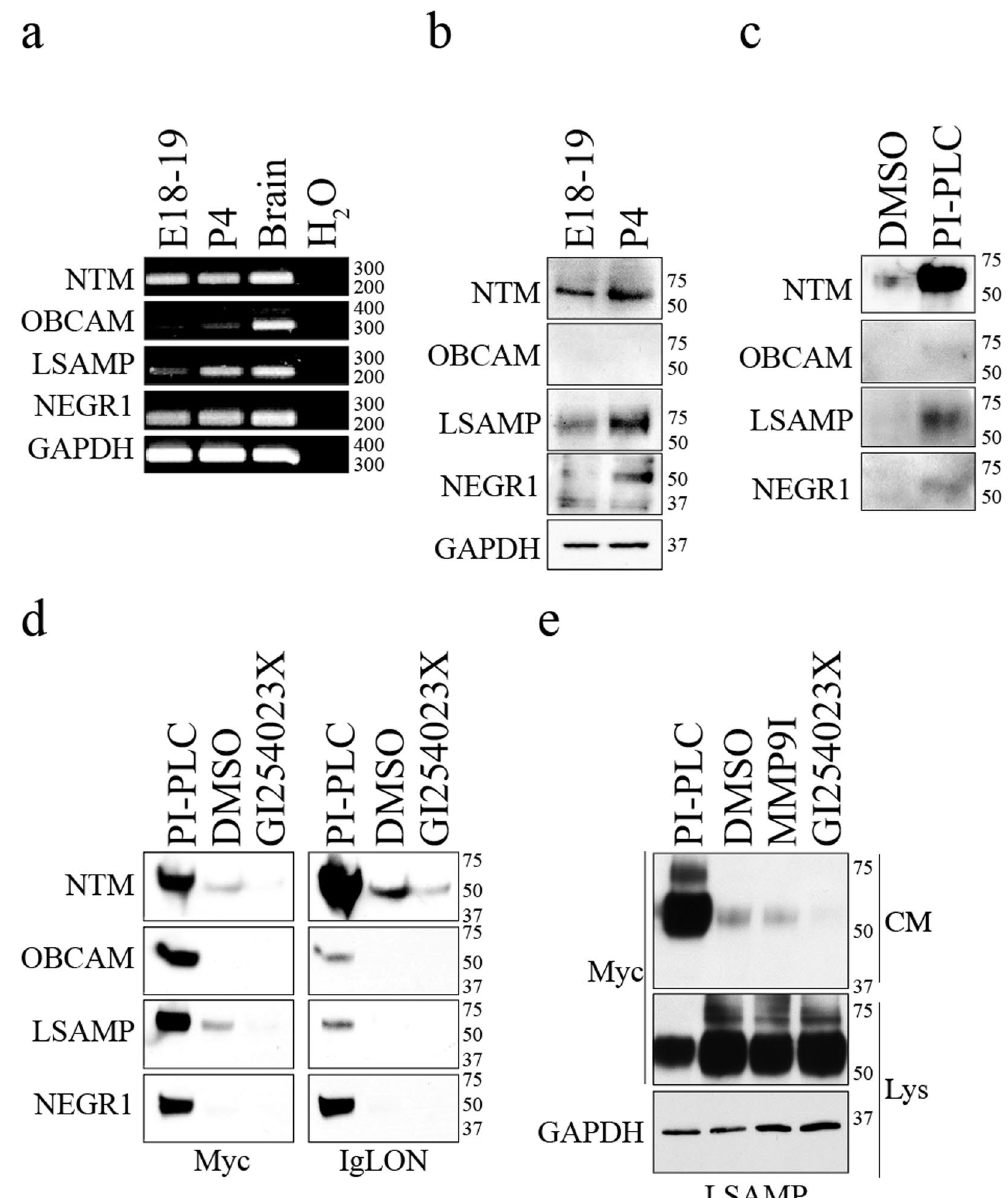
Figure 4. NTM and LSAMP are expressed and shed from the surface of embryonic DRG neurons by ADAM10. ( a ) Reverse transcription PCR (RT-PCR) was performed in DRG neurons from two developmental stages (E18- 19 and P4). Brain RNA was used as a positive control and H 2 O as a negative control. GAPDH RNA expression was analyzed as a loading control. ( b ) Lysates from embryonic (E18) and postnatal (P4) DRG neurons analyzed by Western Blot to assess the expression of endogenous IgLON proteins. GAPDH was analyzed as a loading control. ( c ) Conditioned media from membrane-extracts from (E18-19) DRG exposed to PI-PLC, as a positive control. Commercially available IgLON antibodies were used to detect cleaved IgLON fragments in the media. ( d ) The potency of commercially available IgLON antibodies was assessed by Western Blot. Conditioned media from dissociated embryonic (E18-19) DRG neurons expressing Myc-tagged IgLON constructs were probed with commercial anti-IgLON antibodies and anti-Myc antibodies. ( e ) Western Blot analysis of conditioned media from DRG neurons transduced with myc-tagged LSAMP and treated with the ADAM10 inhibitor GI254023X or the MMP9 inhibitor MMP9I. Western blots were cropped and full length blots are provided in Supplementary Figure